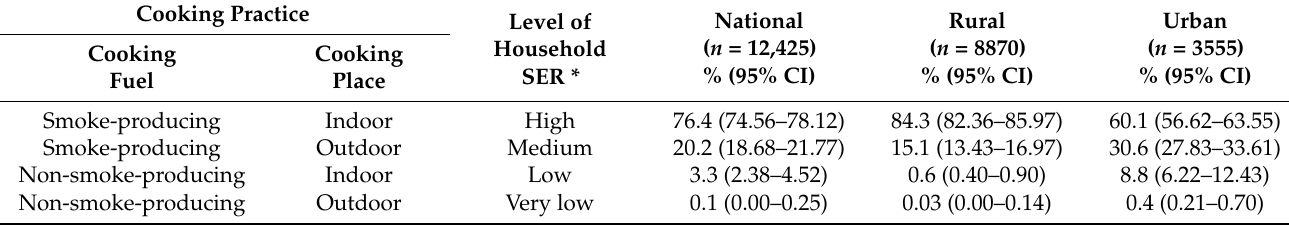
Table 1. Prevalence of household smoke-exposure risks (SERs) in